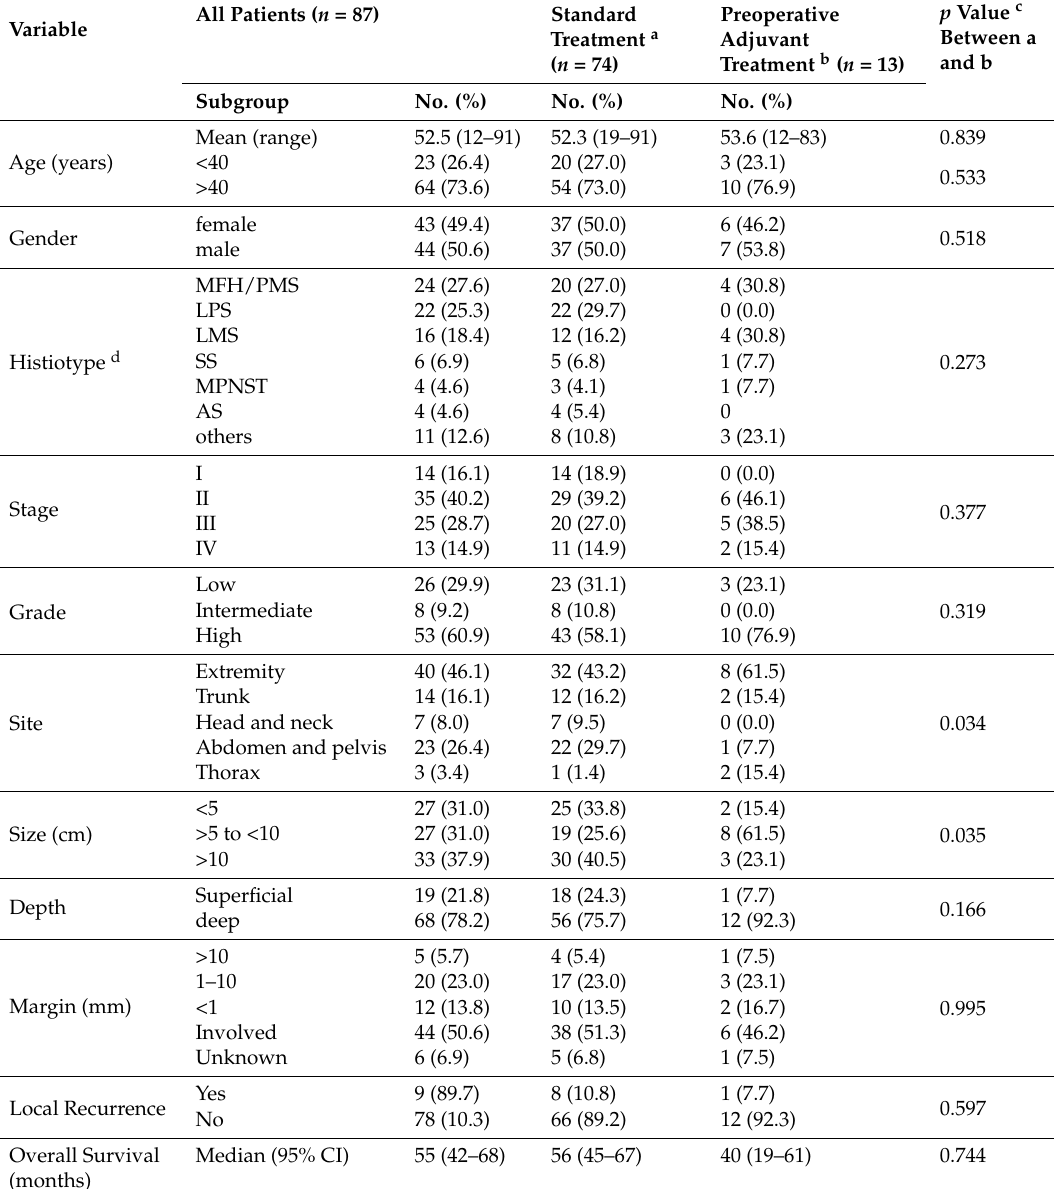
Table 1. Clinicopathological characteristics of soft tissue sarcoma